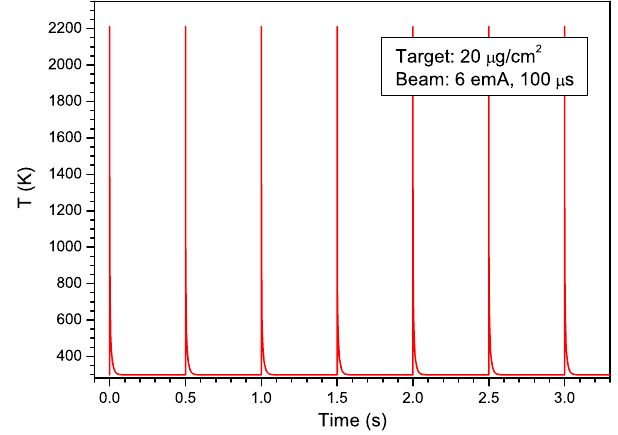
FIG. 4. Temperature vs time at foil center ( r ¼ 0 ), beam pulse repetition rate ¼ 2 Hz, foil thickness ¼ 20 μ g = cm 2 , beam current 6 emA, and pulse length ¼ 100 μ s